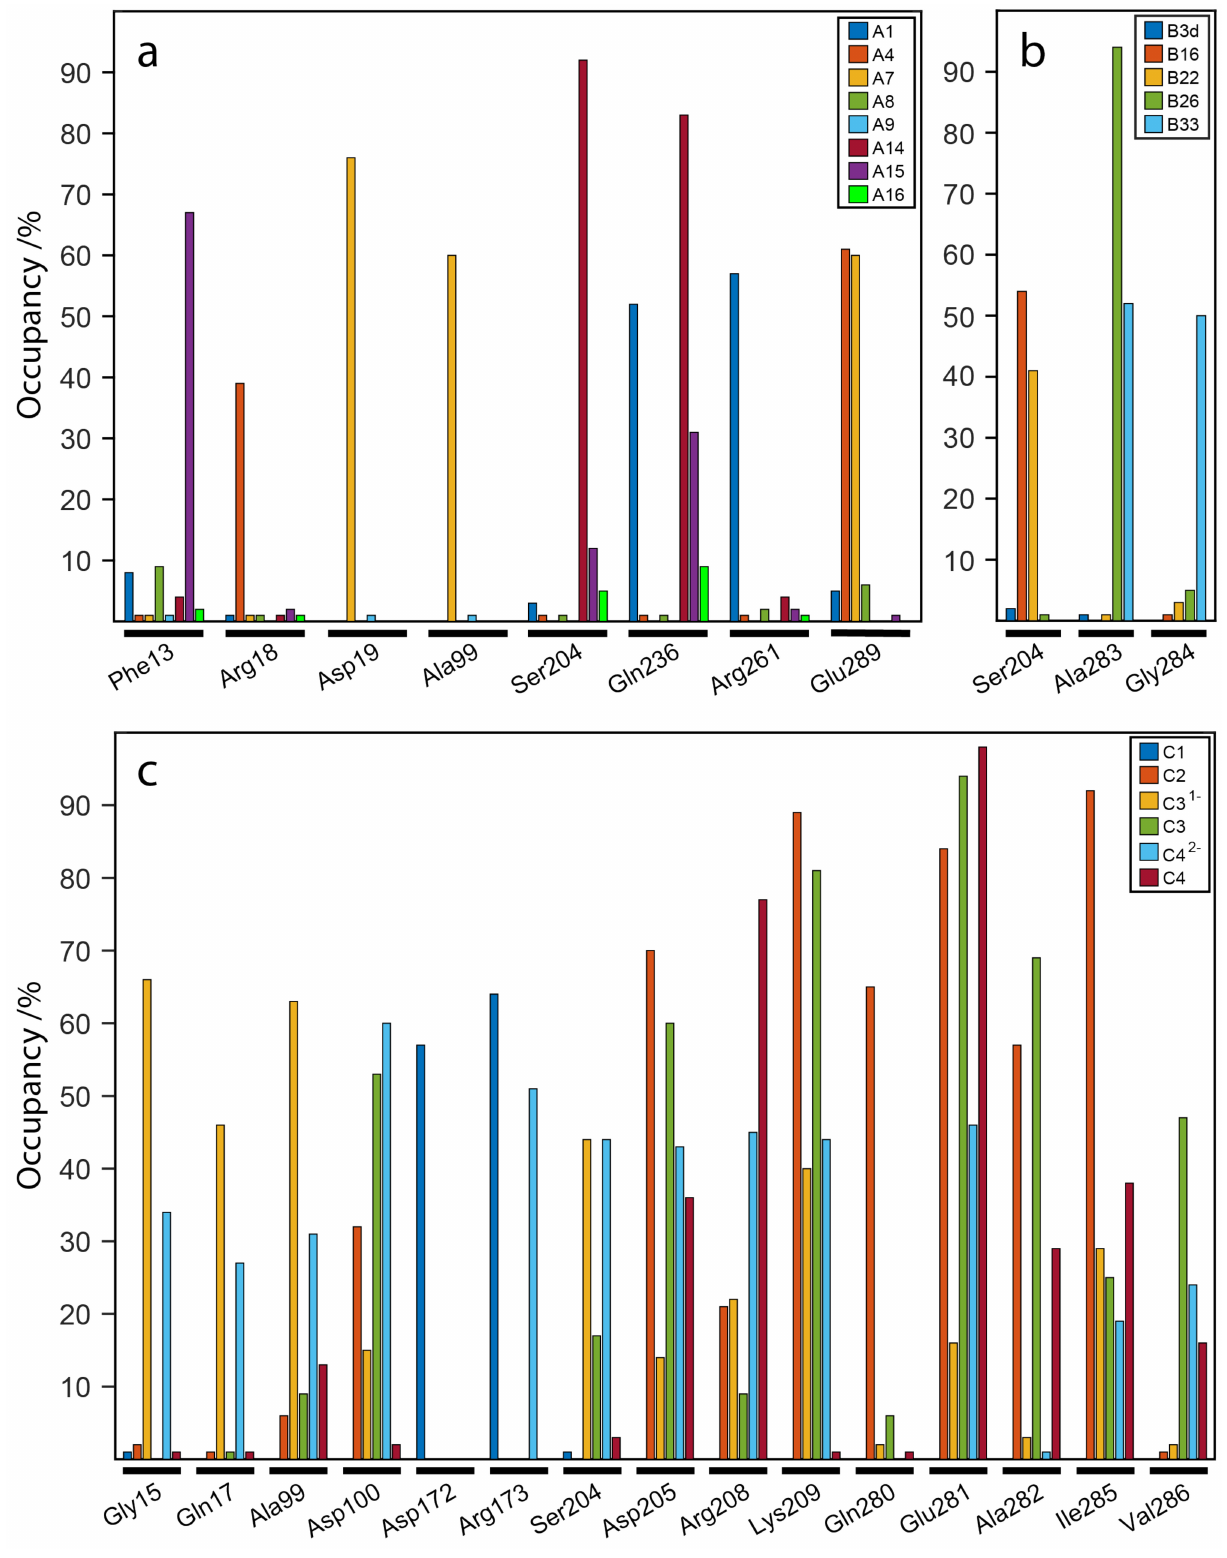
Figure 8. Hydrogen bond occupancies for ligands of ( a ) library A, ( b ) library B and ( c ) library C to the amino acids in the binding pocket of WaaG. Reported amino acids have at least 30% occupancy for one protein/ligand